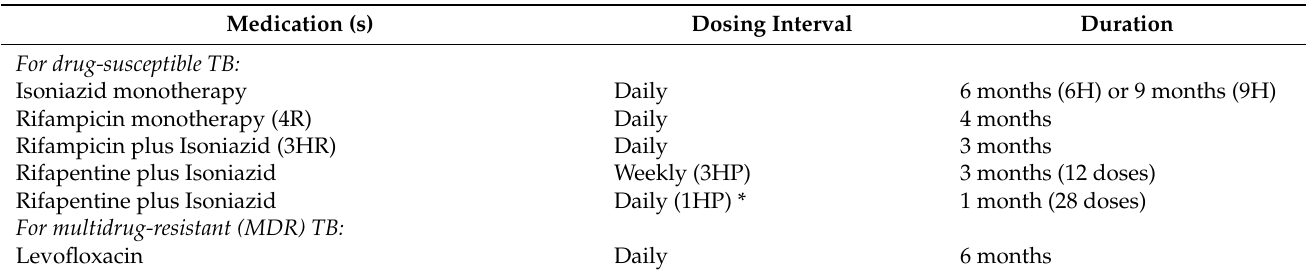
Table 2. TB Preventive Treatment Regimens Recommended by the World Health Organization for Adolescents and Young Adults